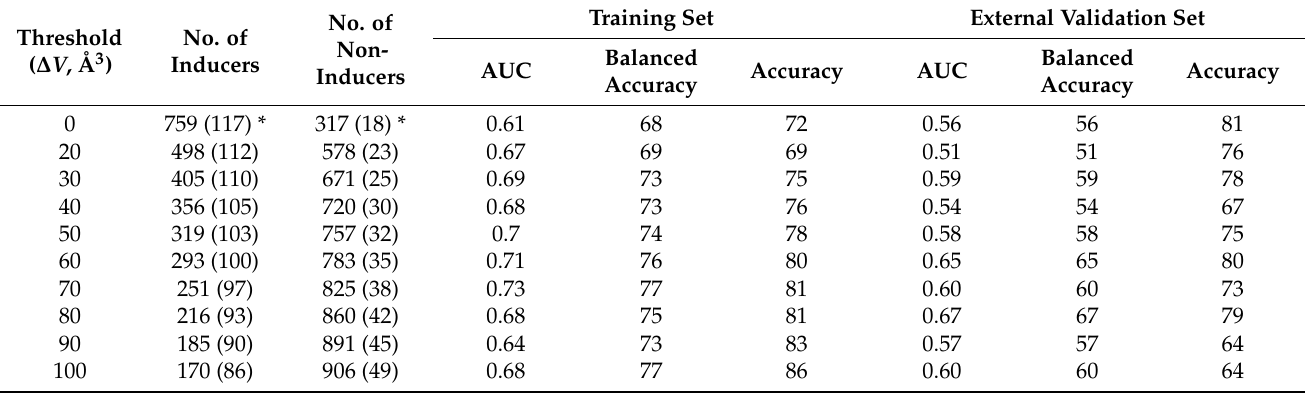
Table 1. Accuracy of classification models when using different